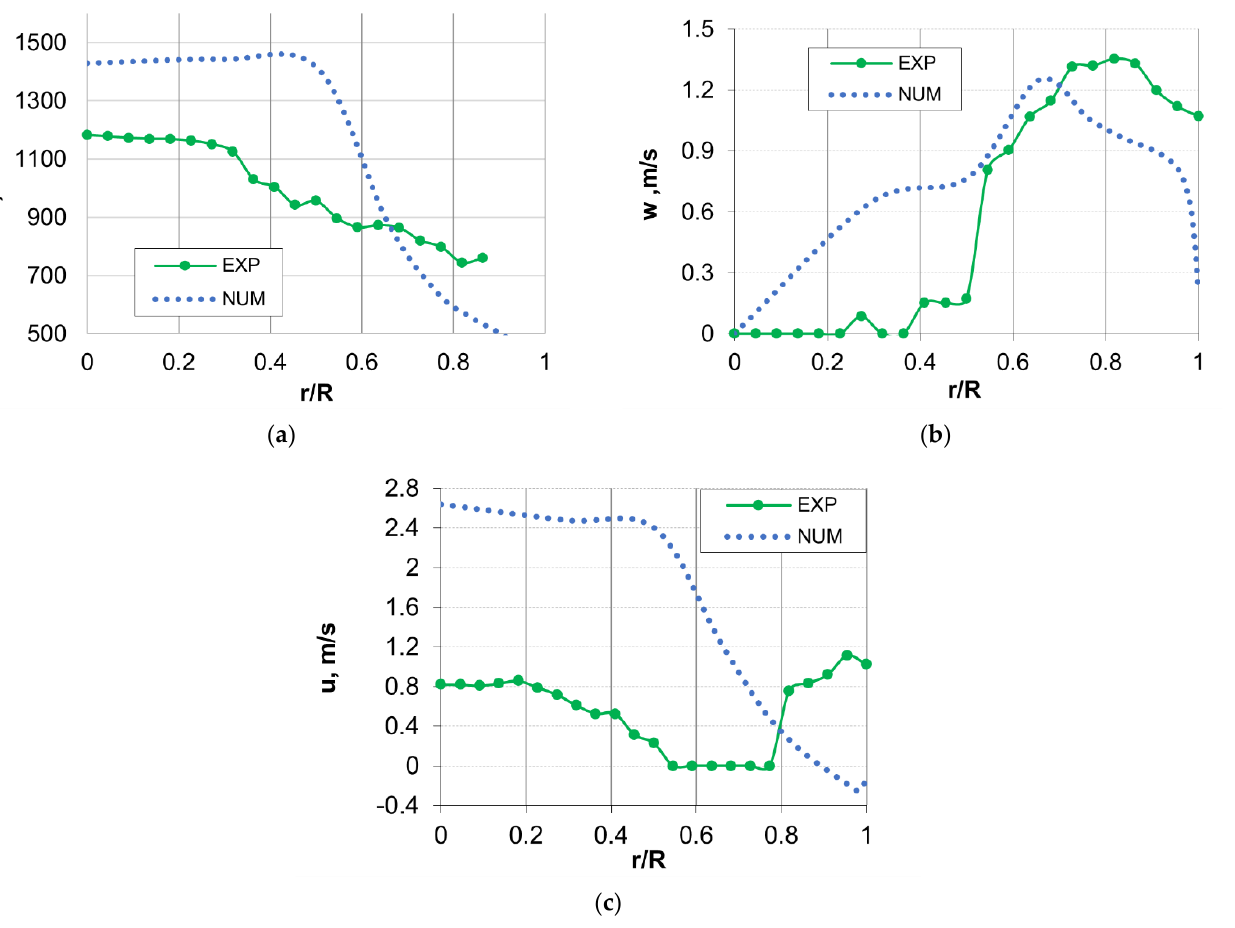
Figure 8. Comparison of experimental and numerical results of raw straw: ( a ) temperature, ( b ) tan- gential velocity, ( c ) axial velocity profiles at L/D = 1.5.